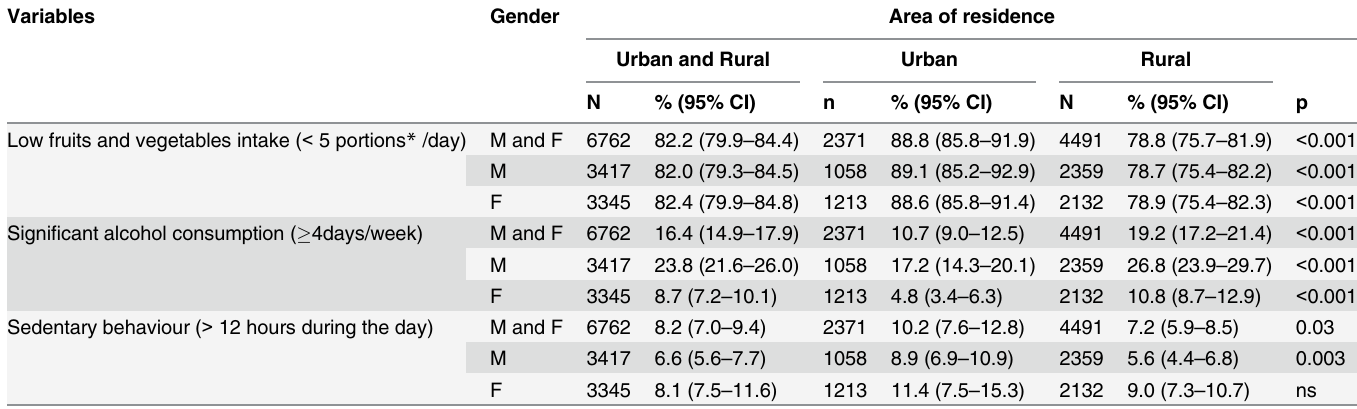
Table 2. Behaviour characteristics in 25 – 64 years population in Benin stratified by area of residence and gender (weighted prevalences from Steps Benin 2008 sample).